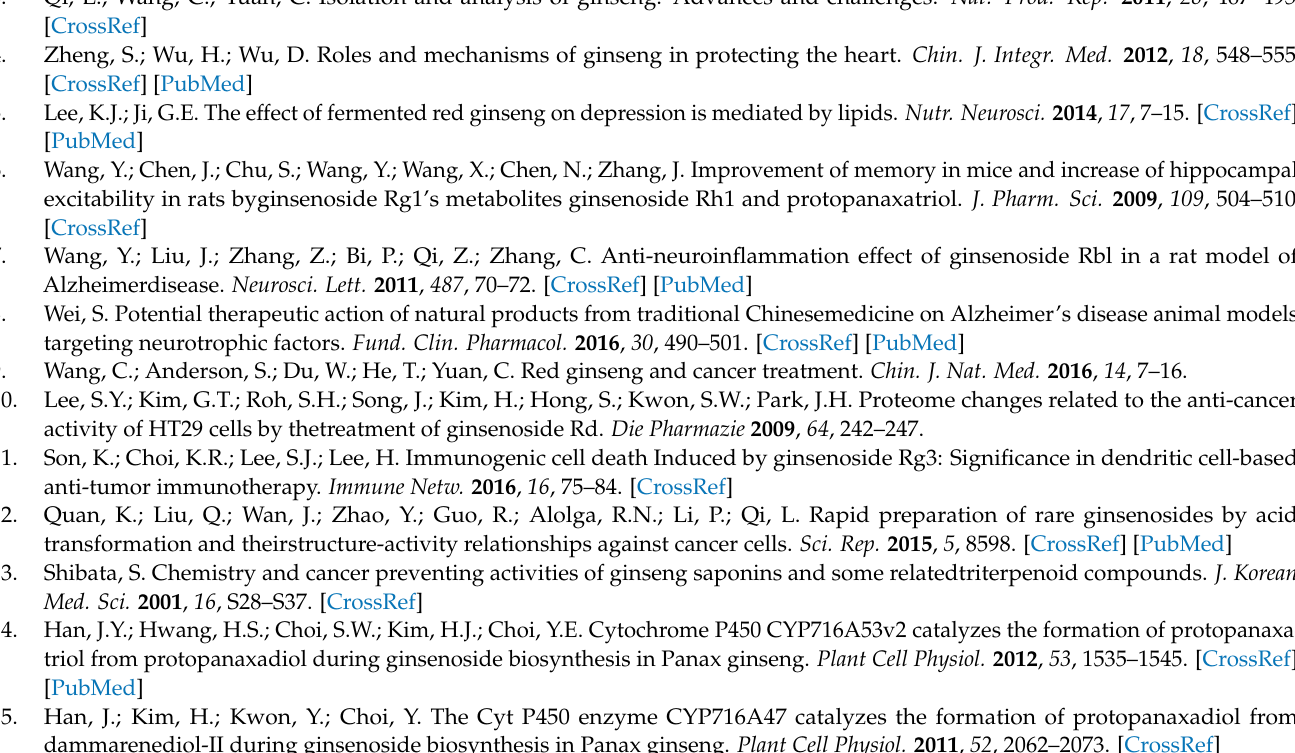
Figure S3: The transmembrane domain of PgCPR1 and PgCPR2; Figure S4: The protein